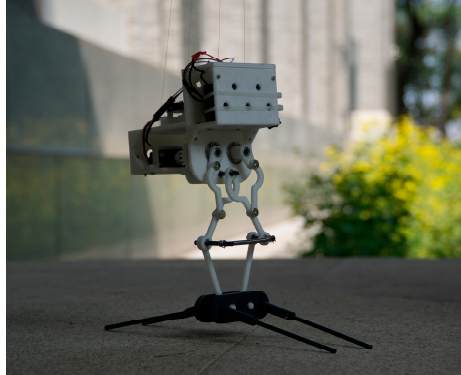
Figure 1. Prototype of the RHop.